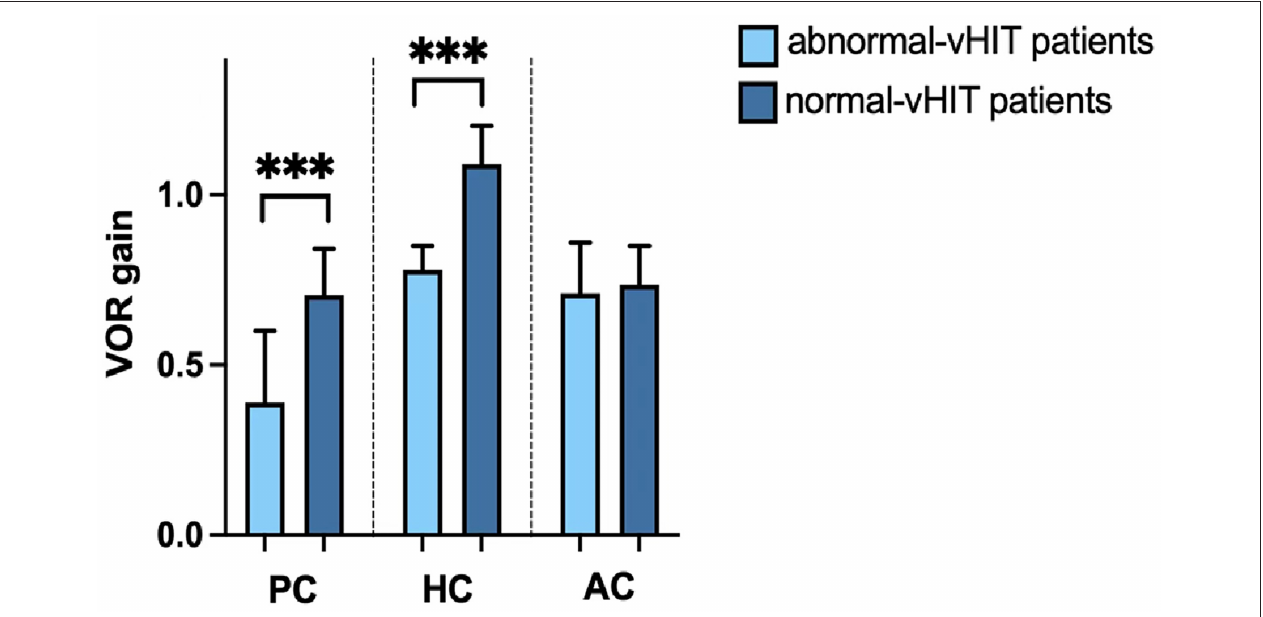
FIGURE 3 | vHIT gains for the posterior canal (PC), horizontal canal (HC), and anterior canal (AC) of patients with s-BPPV with abnormal vHIT results and those with normal vHIT results. *** p < 0.001.